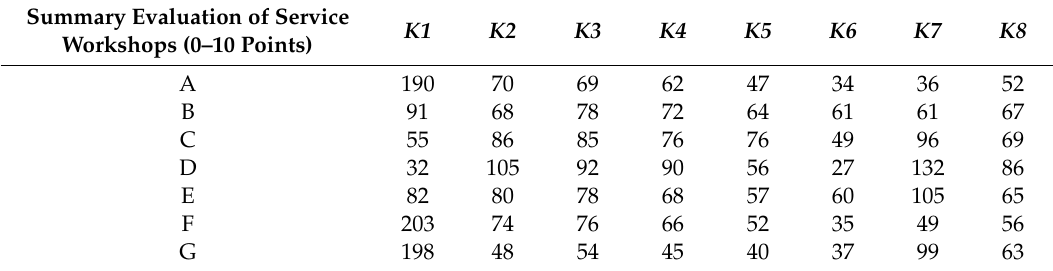
Table 2. Evaluation of the service divisions and hierarchy of decision-making criteria.